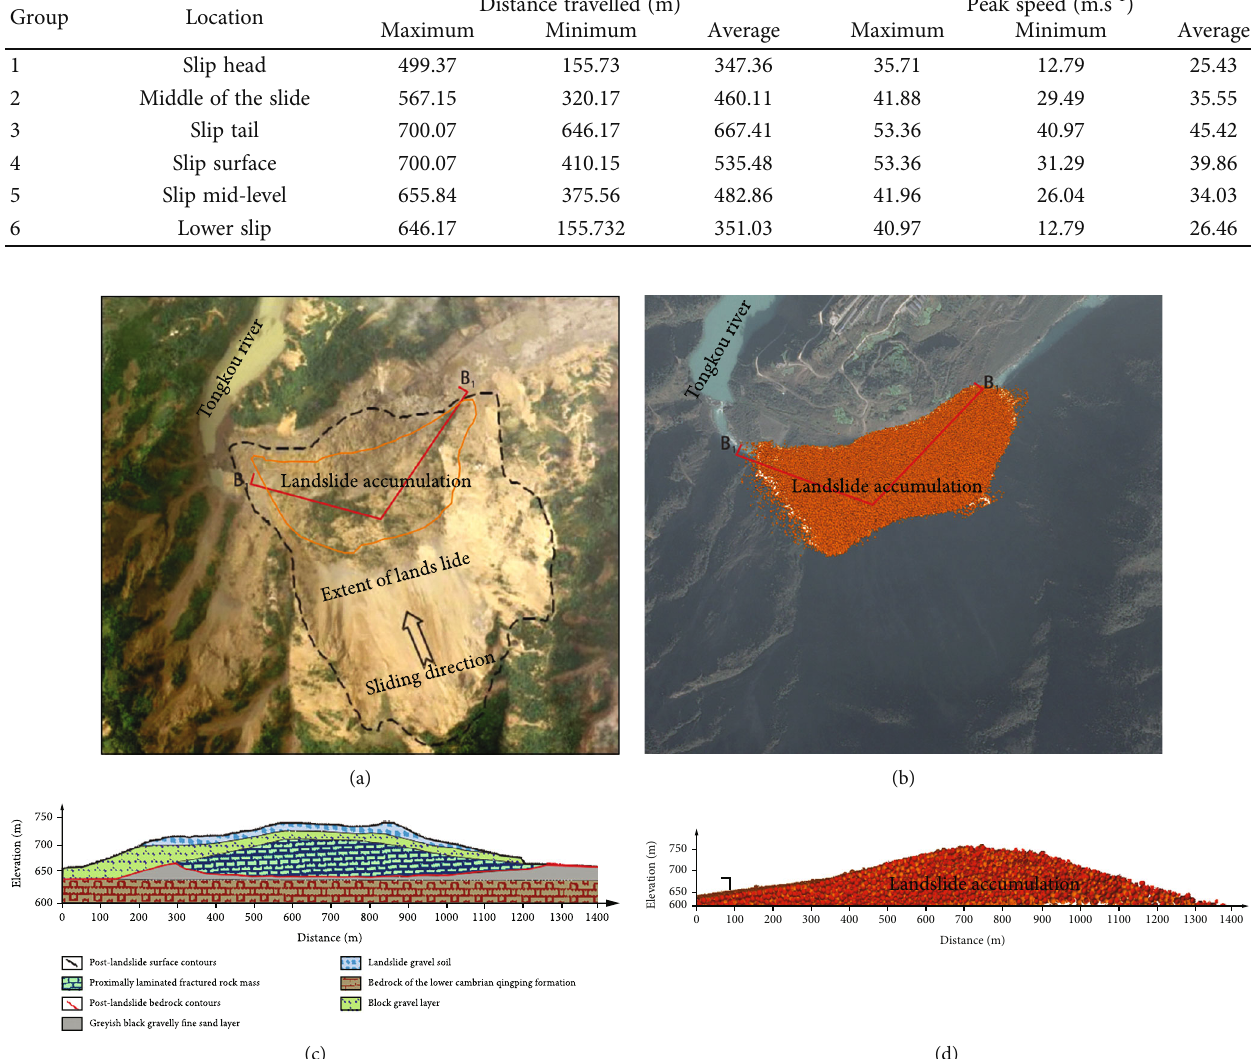
-B section. (d) Weir body b-b pro fi 1 1